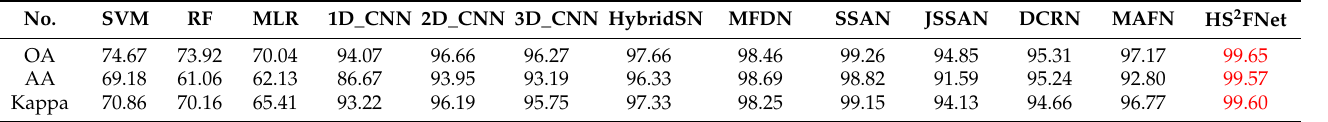
Table 8. Quantitative comparisons of the state-of-the-art models and our network on SA dataset.